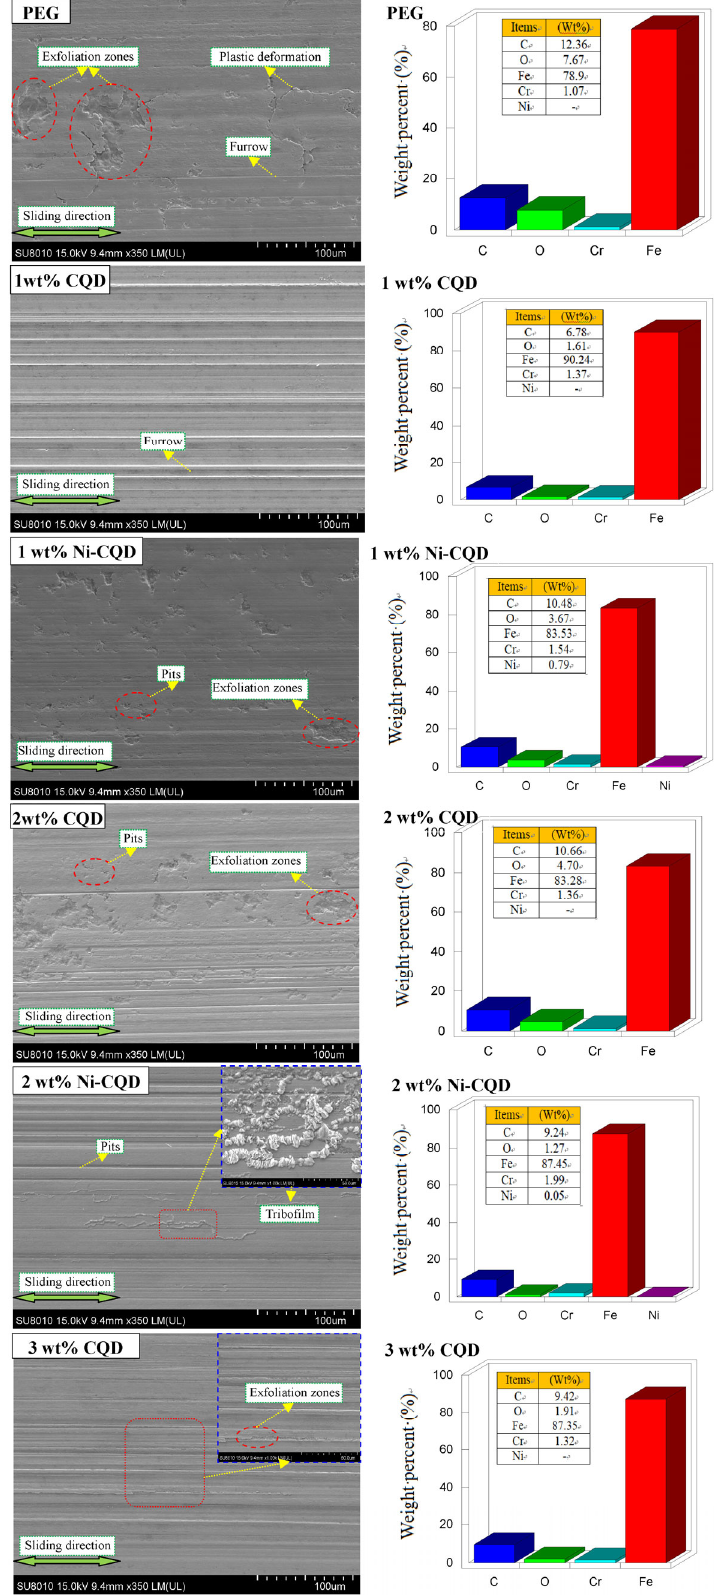
Fig. 9 SEM/EDS analysis of wear zones lubricated with different oil samples at 100 N and 25 mm/s for 60